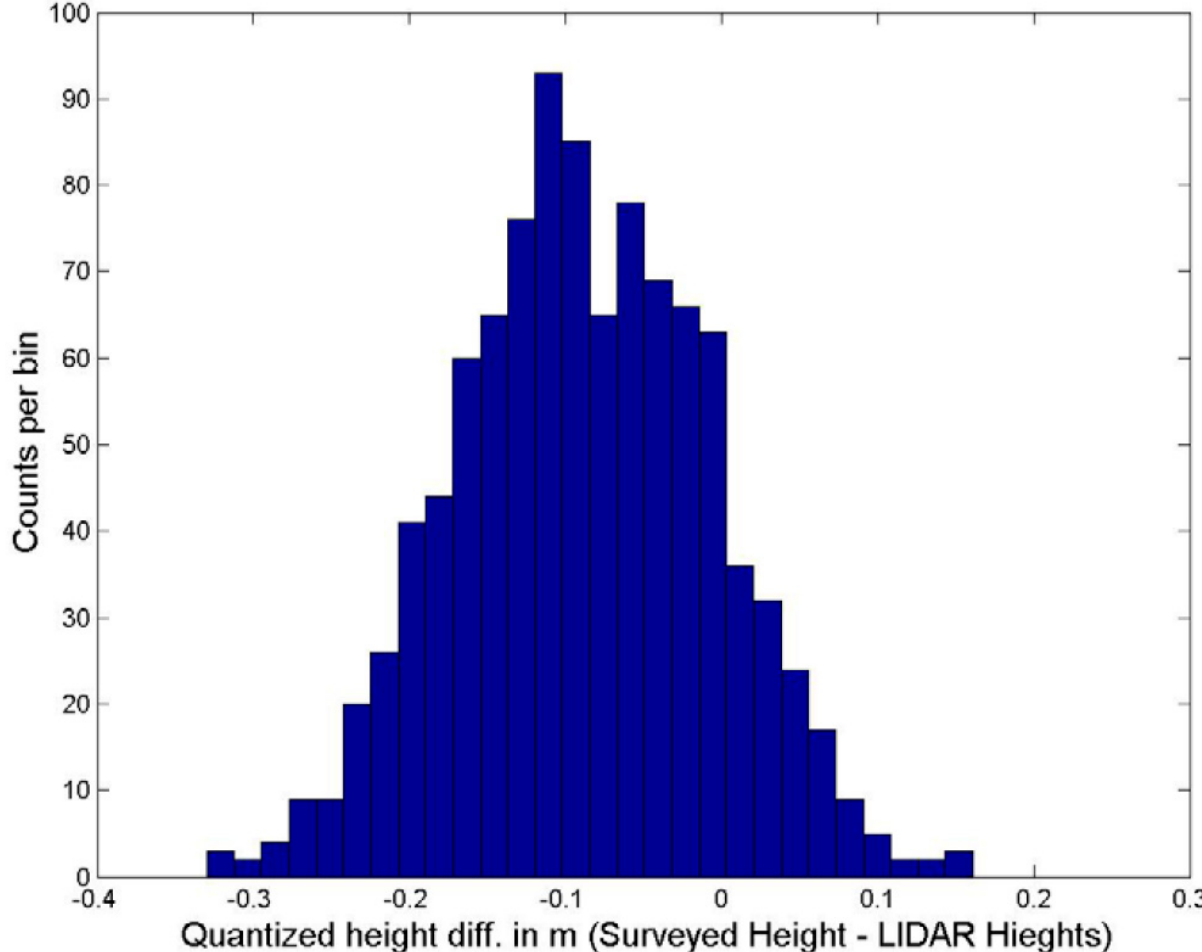
Table 2. Planimetric accuracy results.